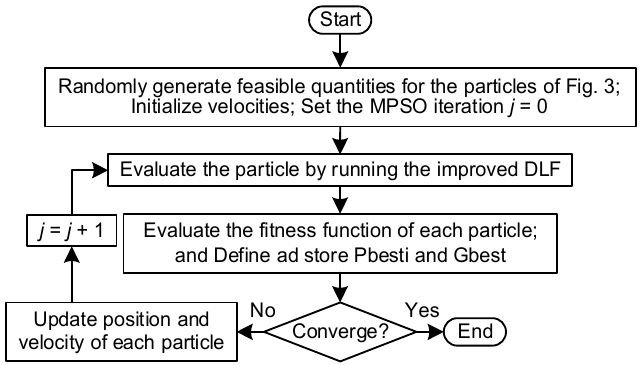
Figure 4. Solution flowchart of modified particle swarm optimization (MPSO) and direct load flow (DLF) based Dynamic optimal power flow (DOPF) solver.